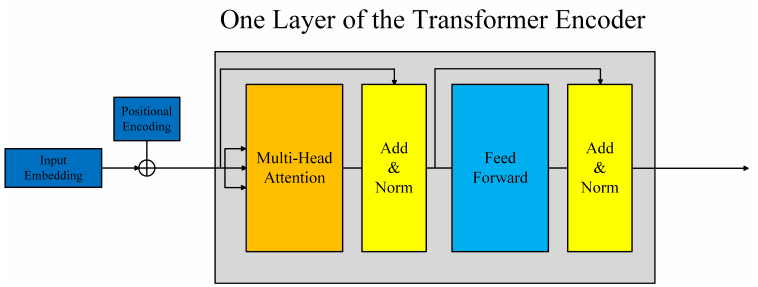
Figure 3. The architecture of the transformer encoder.